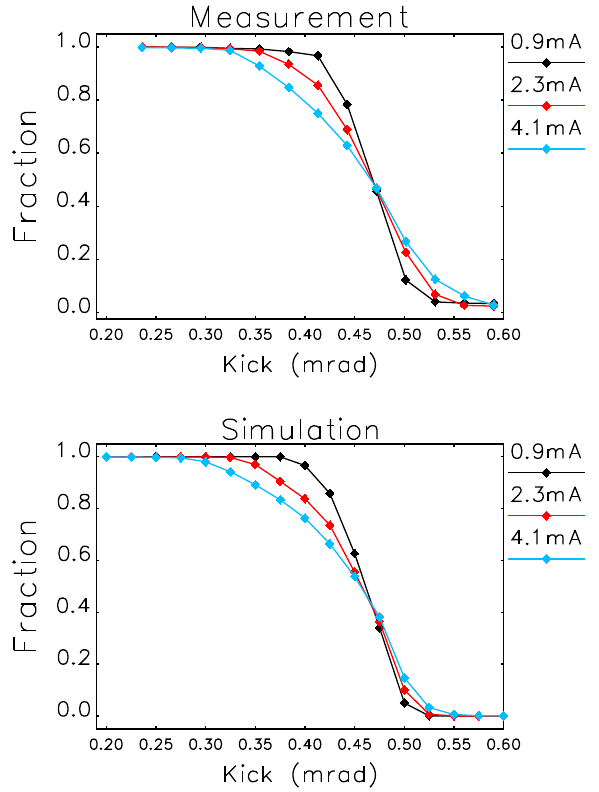
FIG. 4. Horizontal detuning with amplitude. Error bars based on averaging over 270 BPMs are not shown as they are smaller that the symbols on the plot.